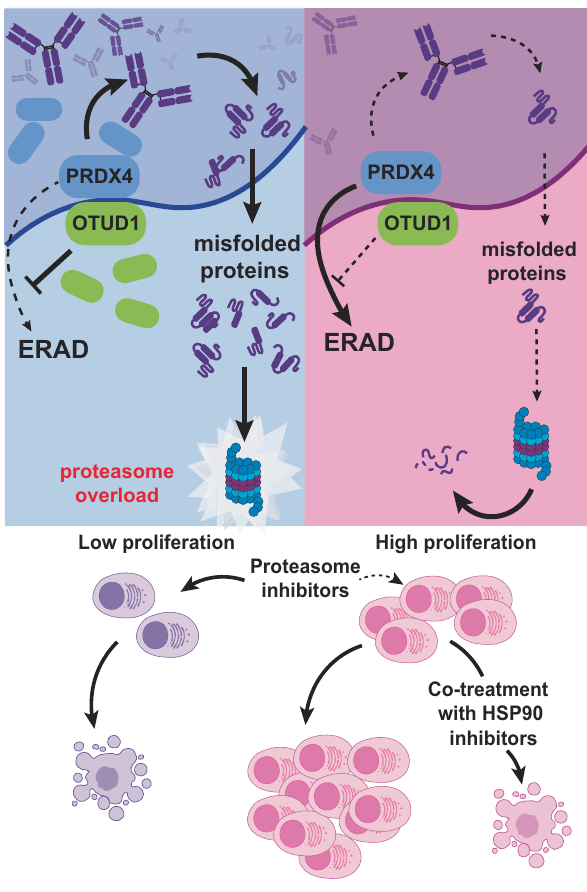
Fig.8|ModelofOTUD1-PRDX4axisregulatingIgproductioninmyelomacells. Suggested mechanistic model of OTUD1 driving MM cells proliferation, Ig folding and PIs sensitivity via modulation of PRDX4 levels together with the proposed rationalcombination treatment to re-sensitize OTUD1low/iIg low MMcellsto PIs. Created with